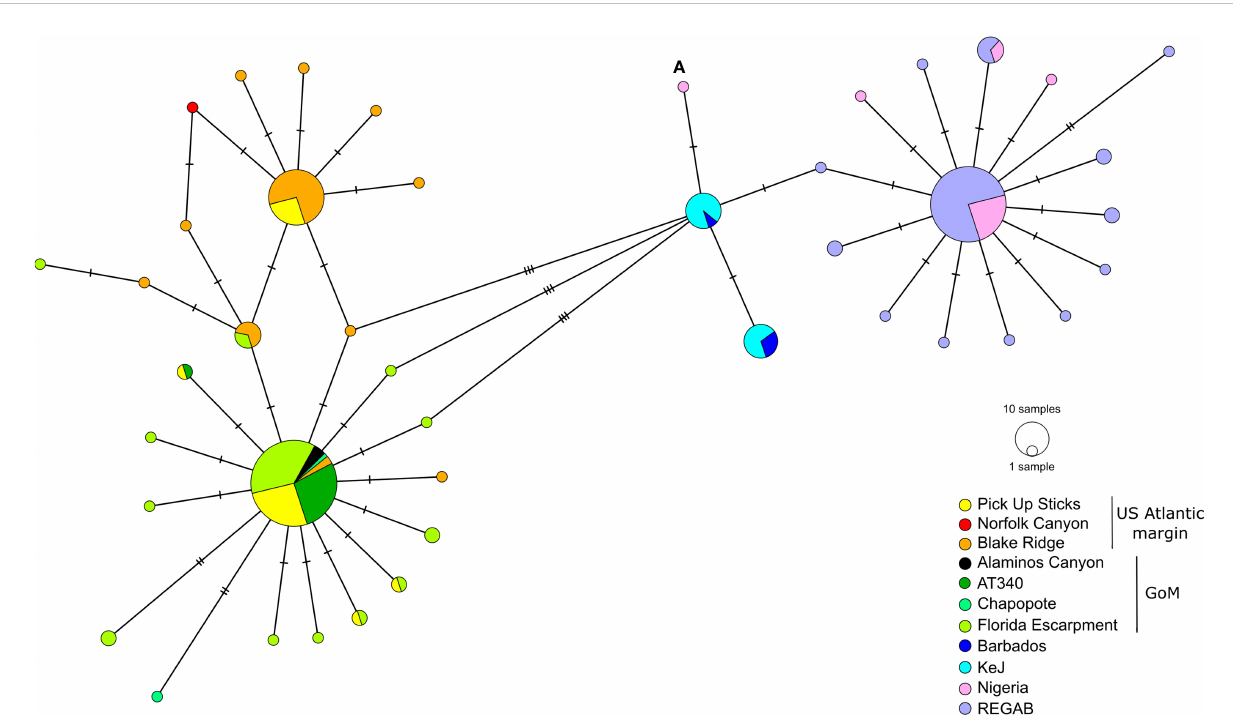
FIGURE 3 Haplotype network for the B. heckerae/B. boomerang species complex. See Table 1 and Supplementary Table S1 for details about sequences included. Individual (A) might represent a migrant from Kick em Jenny (KeJ)/Barbados Accretionary Prism to the Nigerian slope. GoM, Gulf of